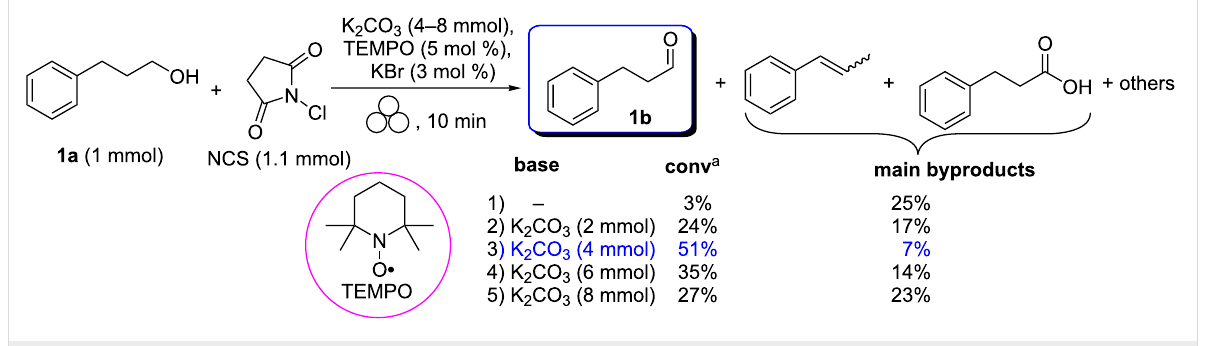
Scheme 1: Oxidation of 3-pheny-1-propanol ( 1a ) with N -chlorosuccinimide (NCS) in the presence of (2,2,6,6-tetramethylpiperidin-1-yl)oxyl (TEMPO) under mechanical activation conditions [50]. a Percentages of conversion were calculated by GC–MS using an internal reference